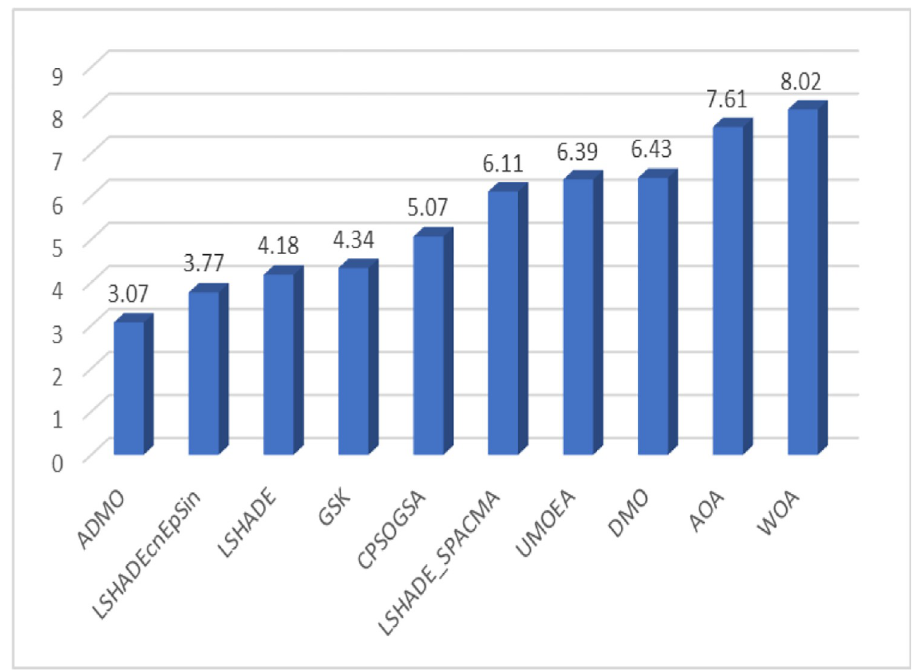
Fig 7. Graphical representation of algorithm’s performance